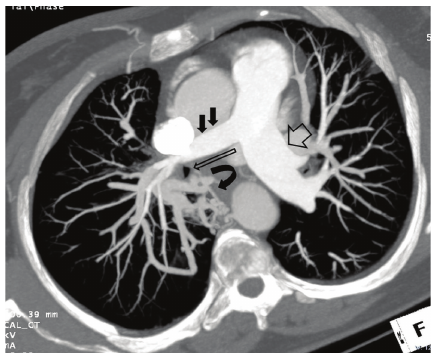
Figure 4: On Axial MIP CT image; at the upper and lower branches of the right main pulmonary artery (black arrows) di ff use hypoplasia, left main pulmonary artery (open thick arrow), hypoplasia of the right intermediate and middle lobe bronchus (open long arrow) was detected.